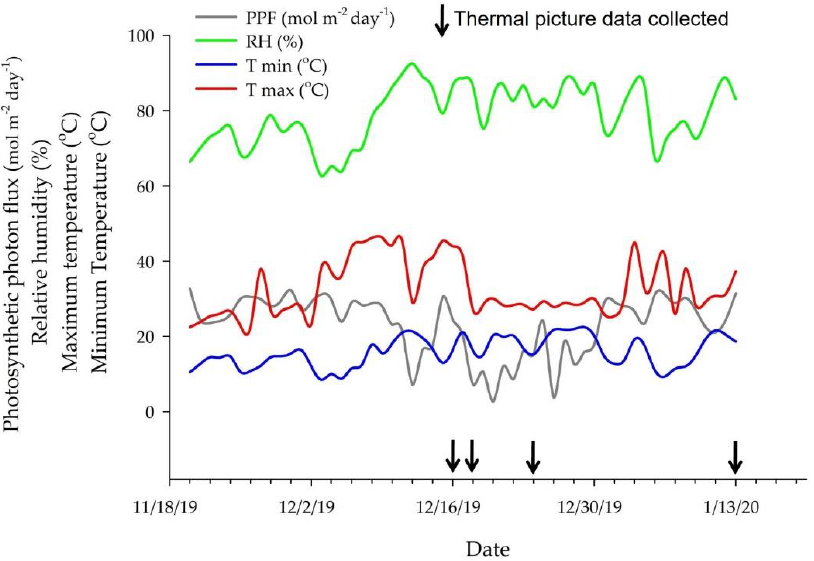
Figure 2. Environmental data inside the greenhouse during the trial showing photosynthetic photon flux density (PPF), relative humidity (RH), maximum (T max ), and minimum (T min ) temperatures during the experimental period and the days in which data were collected.